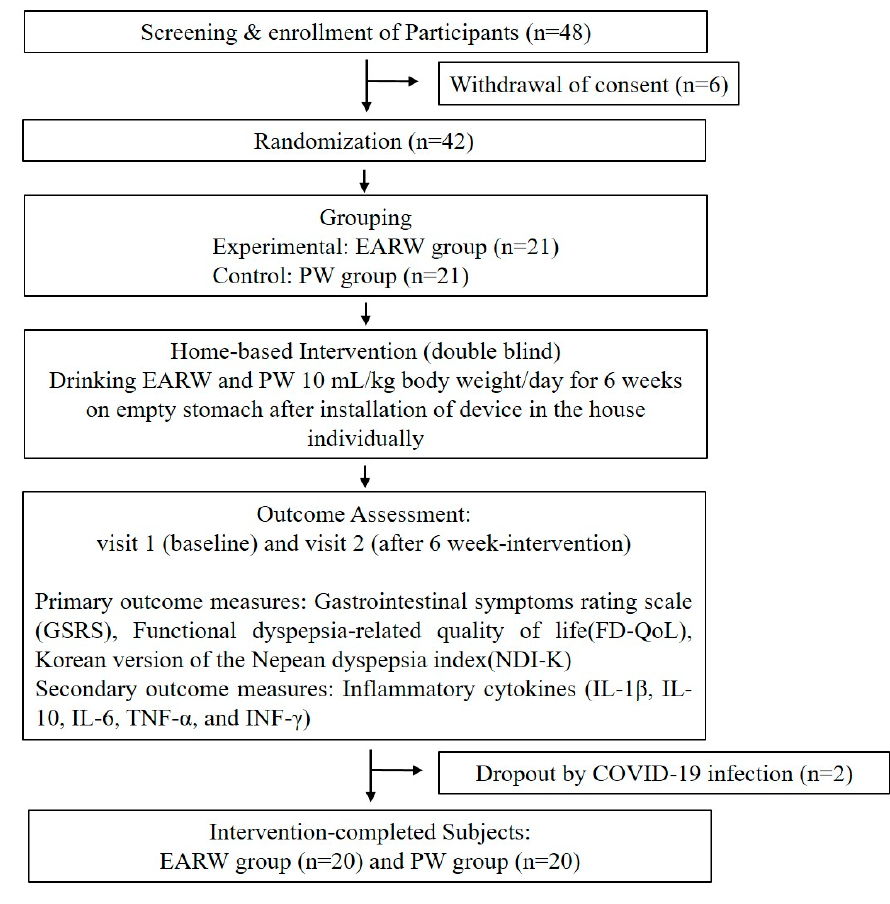
Figure 1. Flow chart of the clinical trial. Abbreviations: EARW: electrolyzed alkaline-reduced water; FD-QoL: functional dyspepsia-related quality of life; GSRS: gastrointestinal symptom rating scale; IFN- γ : interferon-gamma; IL: interleukin; NDI-K: Nepean dyspepsia index; PW: puri fi ed water; TNF- α : tumor necrosis factor alpha.